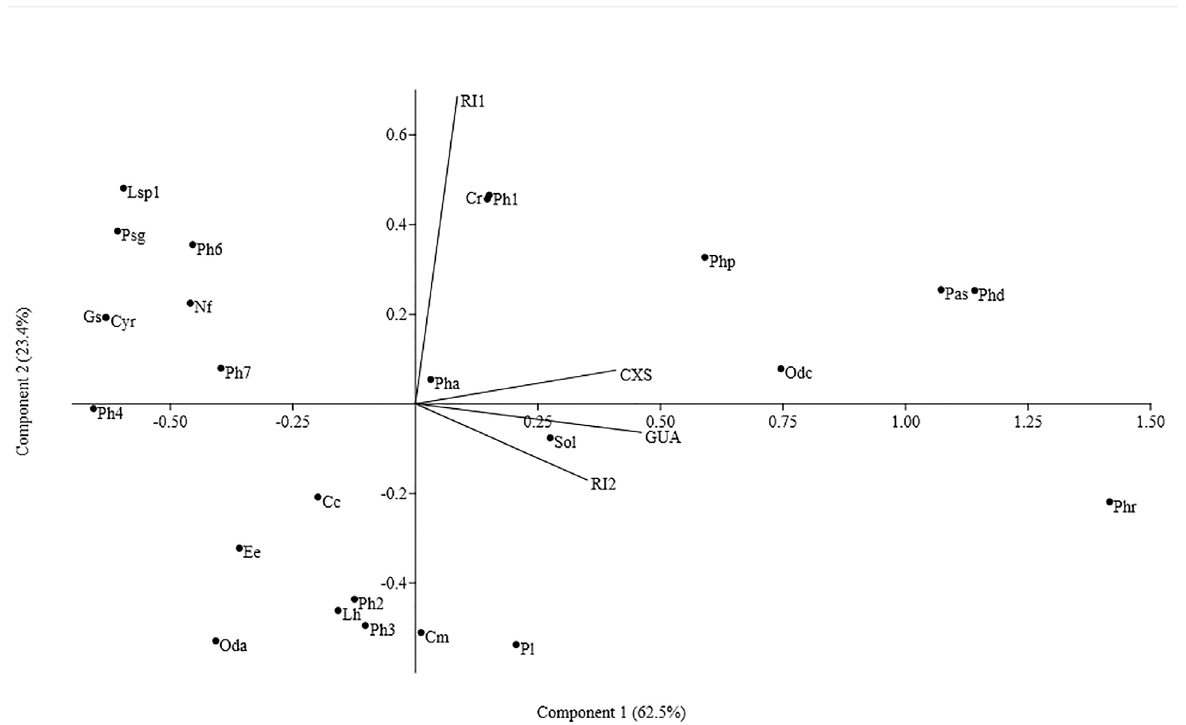
Figure 3 - Principal Component Analysis (PCA) of the ant species at four sites (Guatambu (GUA) and Caxambu do Sul (CXS) in Santa Catarina, and Rio dos Índios (RI1 and RI2) in Rio Grande do Sul). Guatambu (GUA) and Caxambu do Sul (CXS) sites are in Santa Catarina, and both Rio dos Índios sites (RI1 e RI2) are in Rio Grande do Sul. Species abbreviations are as follows: Cc: Camponotus ( M. ) crassus ; Cm: Camponotus ( M. ) mus ; Cr: Camponotus ( M. ) rufipes ; Cyr: Cyphomyrmex rimosus ;